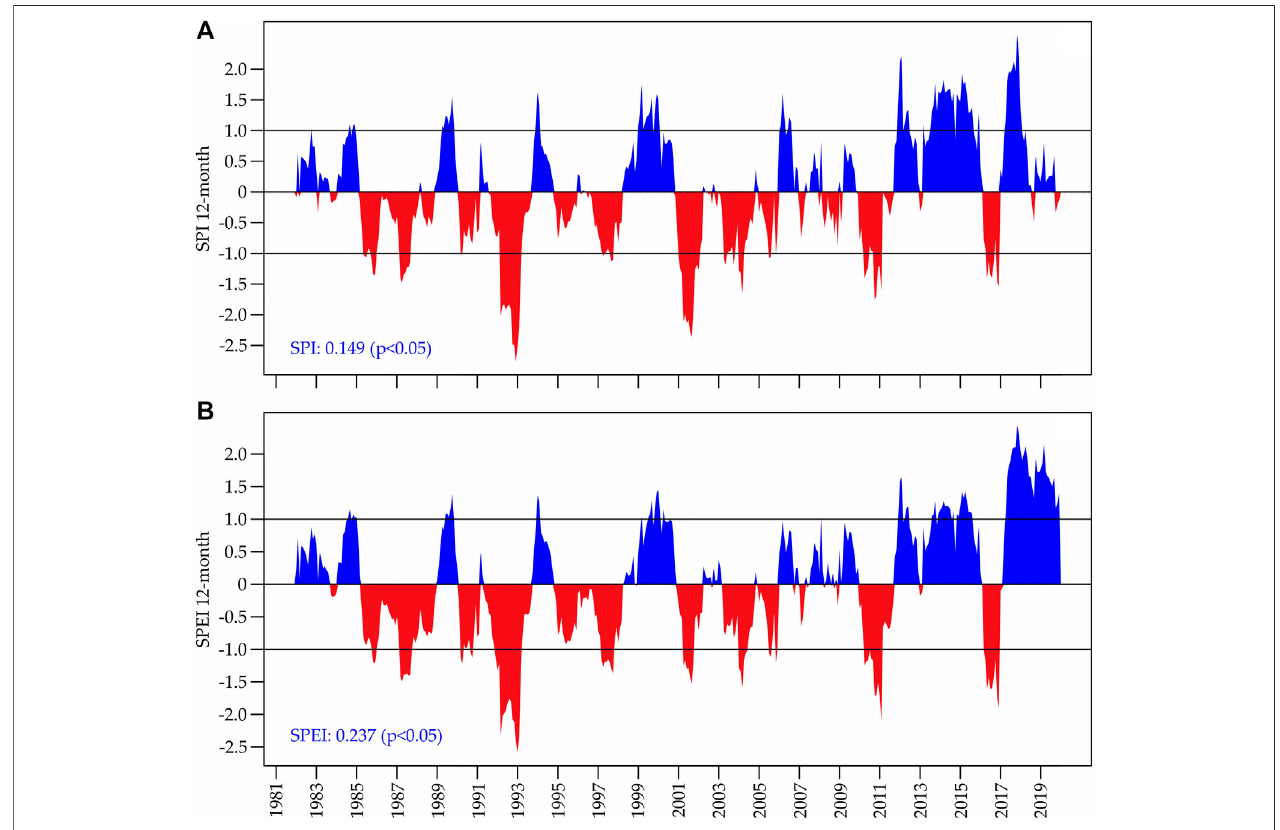
FIGURE 6 | SPI 12-months (A) and SPEI 12-month (B) for the 1981 – 2019 period with wet, normal and drought bands. The amount of change (including the statistical signi fi cance) for each index is shown at the left bottom of each subgraphic.